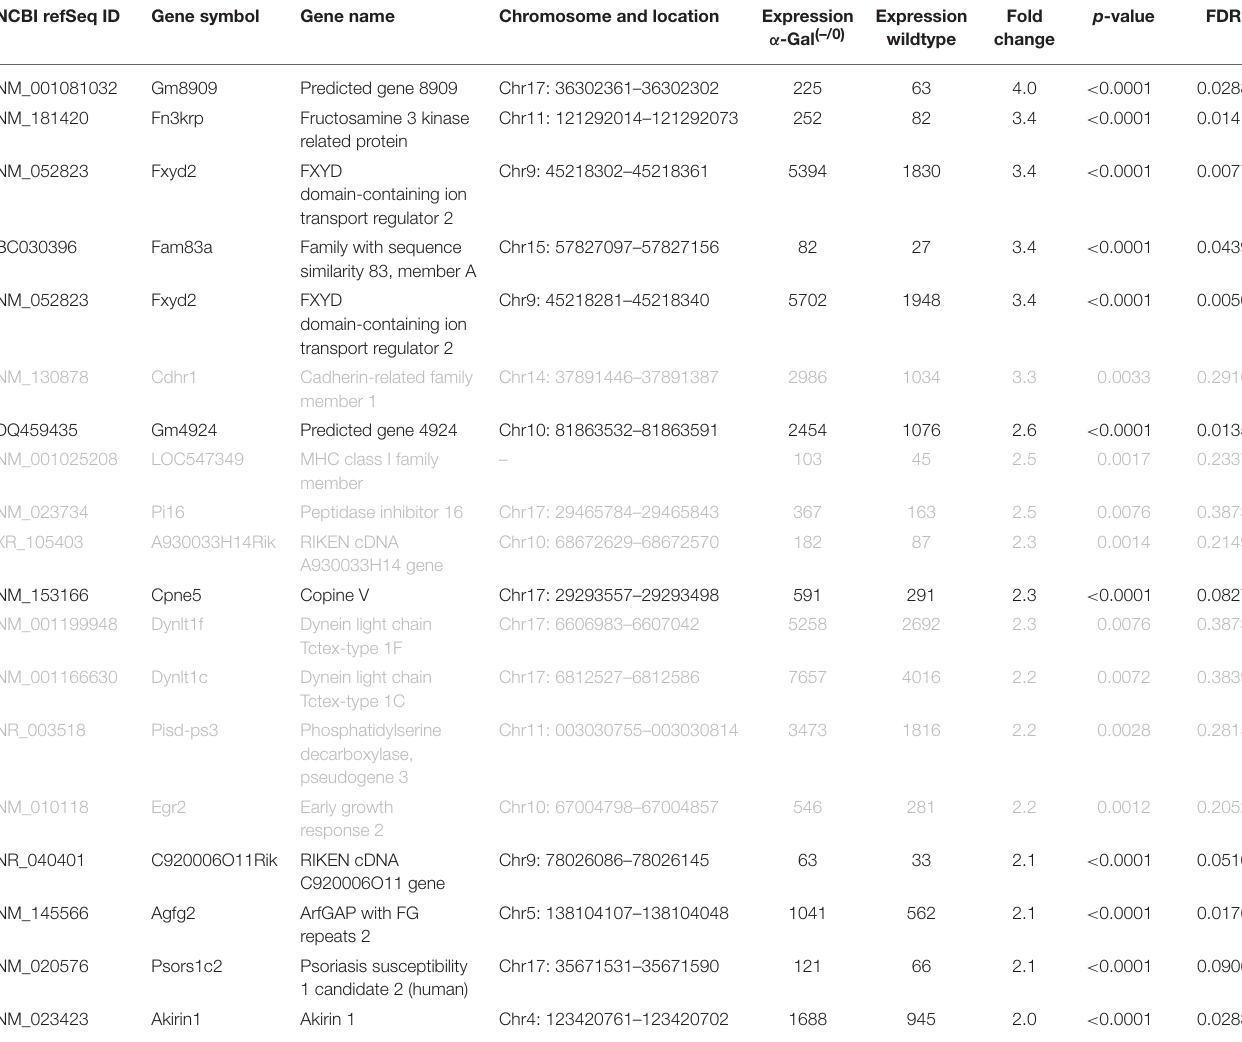
TABLE 1 | Raw expression values, fold changes, and statistical analysis for significantly upregulated